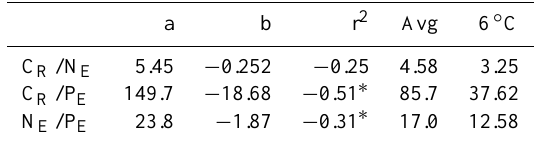
Table 6. Parameters of the linear regression equations relating tem- perature in ◦ C and the metabolic quotients (atoms). ∗ : Significant correlations ( p > 95%). Avg: Quotients for the average “in situ” temperature. 6 ◦ C: Quotients for a temperature increase of 6 ◦ C.